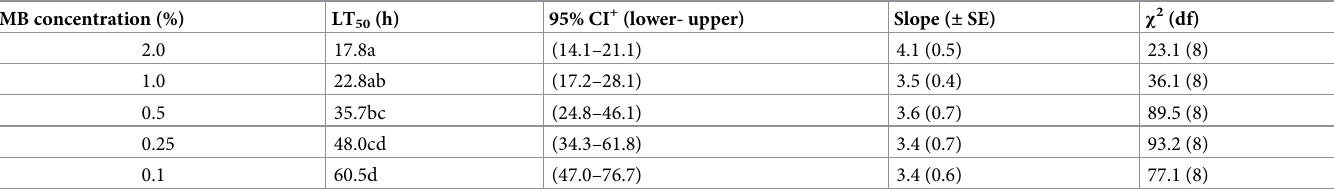
Table 2. Comparing LT 50 against Bemisia tabaci adults, treated with different methyl benzoate (MB) concentrations in a residual assay (n = 60). MB concentration (%)